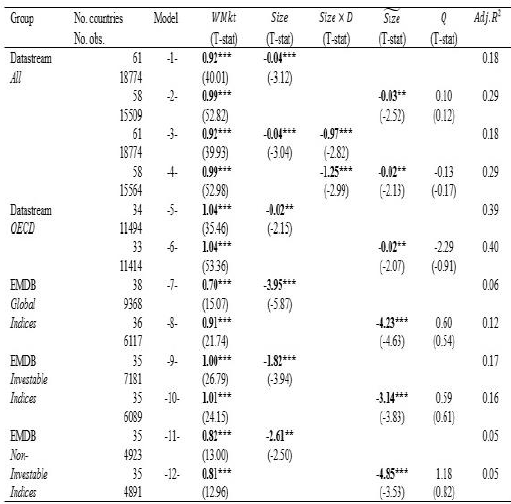
Table 6: Size Effects, Panel Data Regressions